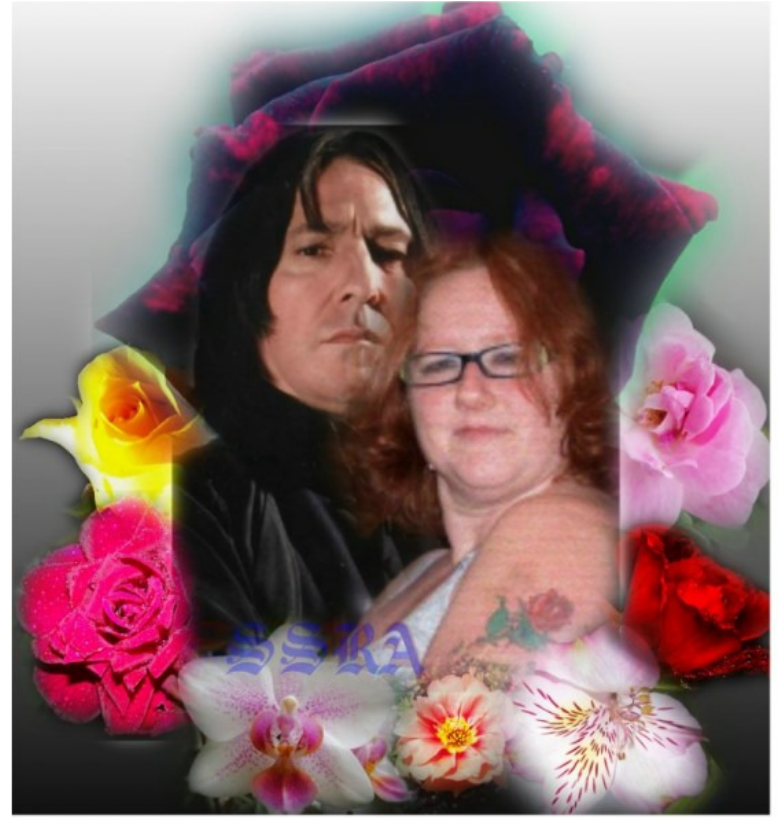
Figure 12. Snape and Rose with flowers in happier days